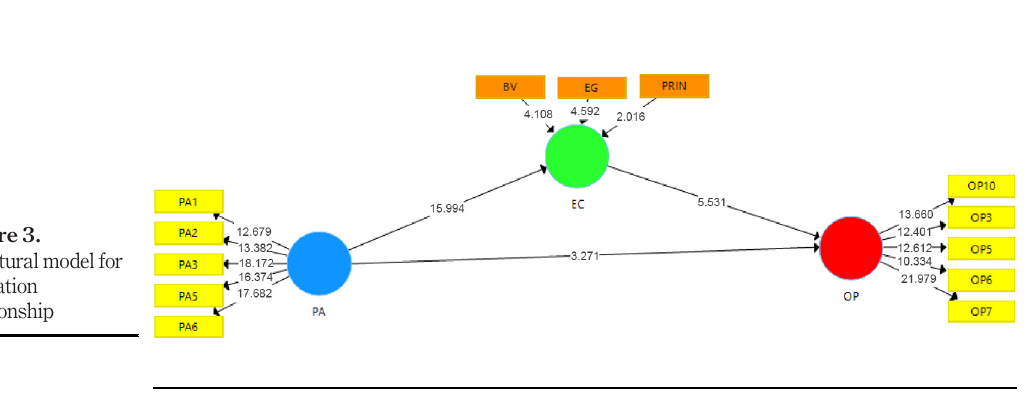
Table VI. Variance explained in the endogenous latent constructs